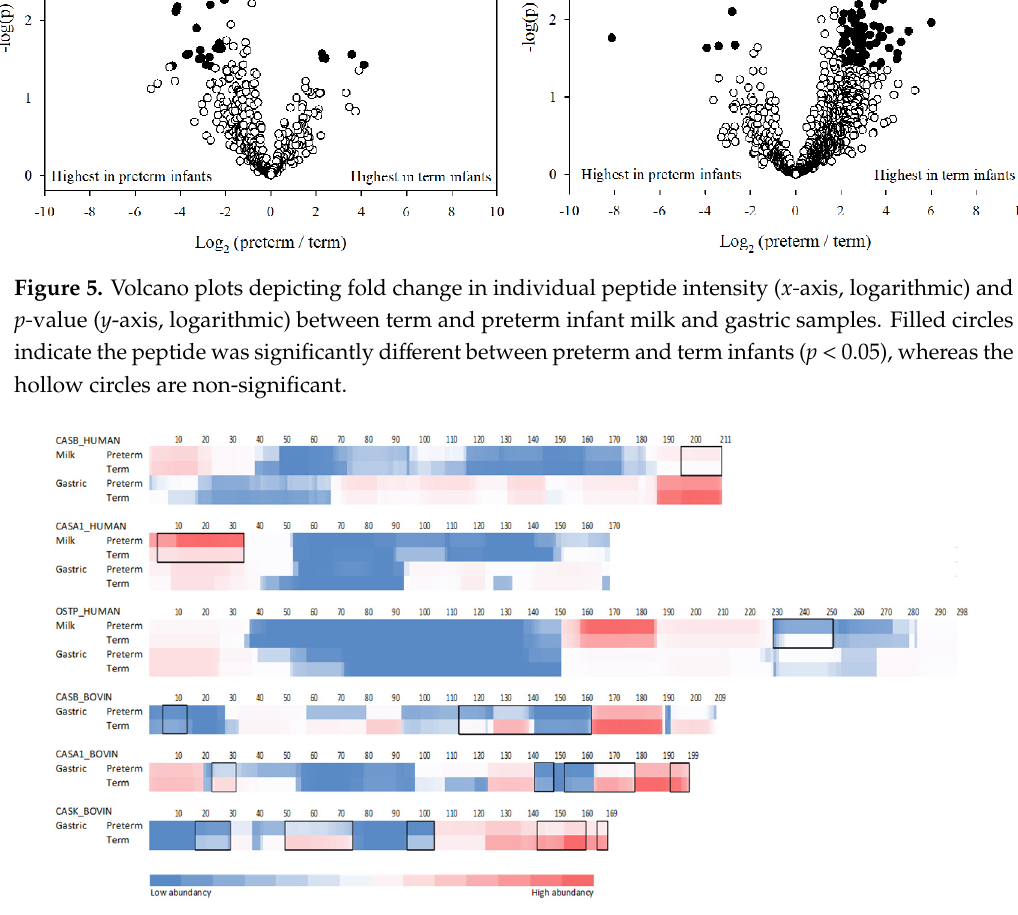
Figure 6. Abundance of peptides identified in mother’s milk and gastric samples from term and preterm infants mapped to the sequence of human and bovine β -casein (CASB), osteopontin (OSTP), α s1 -casein (CASA1), and κ -casein (CASK) . Areas with black borders mark significant difference ( p < 0.05) between ion intensity of peptides at each amino acid site.